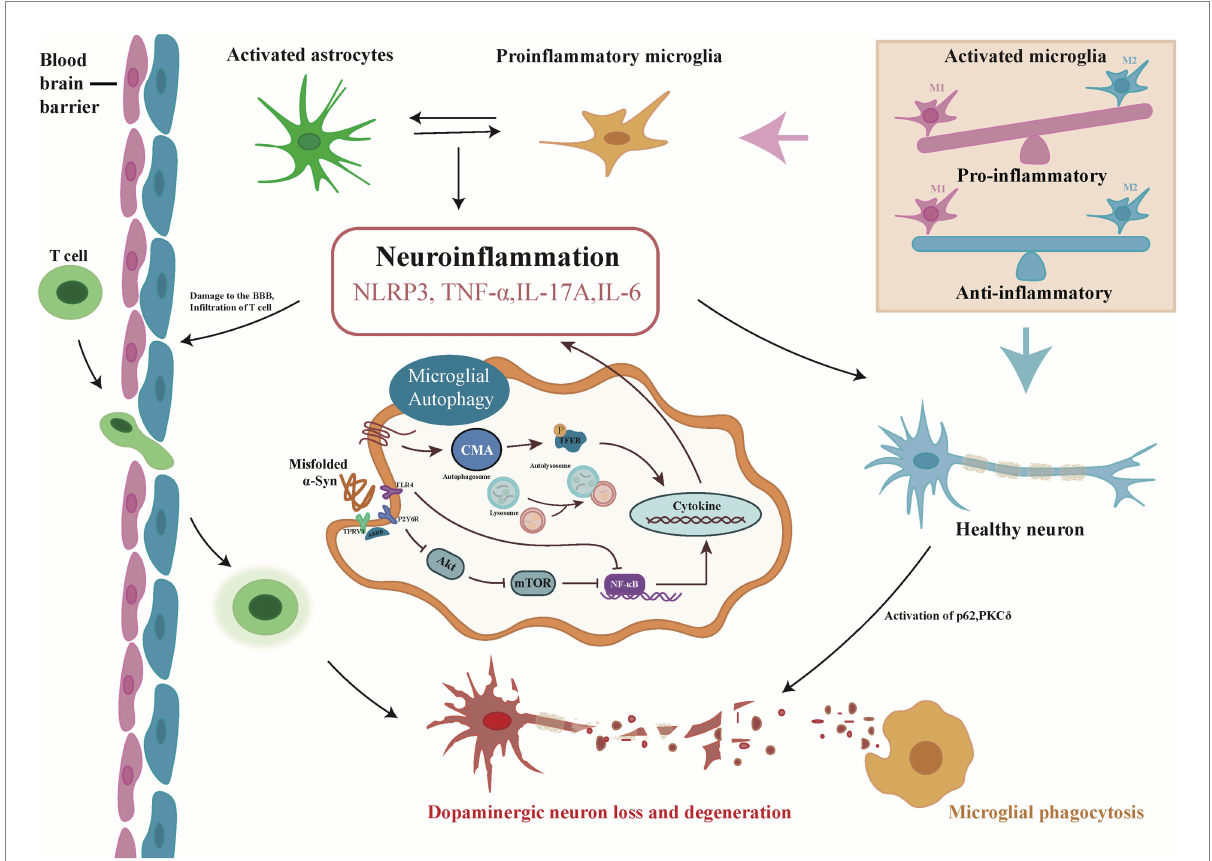
FIGURE 1 Overview of the microglial autophagy process in Parkinson’s disease. Misfolded α -Syn triggers autophagy in microglia, induces neuroinflammation and releases pro-inflammatory cytokines through canonical (Akt/mTOR), noncanonical (TLR4), and chaperone-mediated (CMA) autophagy pathways. Inflammatory factors accelerate the damage and loss of dopaminergic neurons by disrupting the blood–brain barrier and activating PKC δ , p62, etc., triggering the next autophagy. In the process, pro-inflammatory cytokines, in turn, activate resting microglia, which further activate astrocytes and accelerate